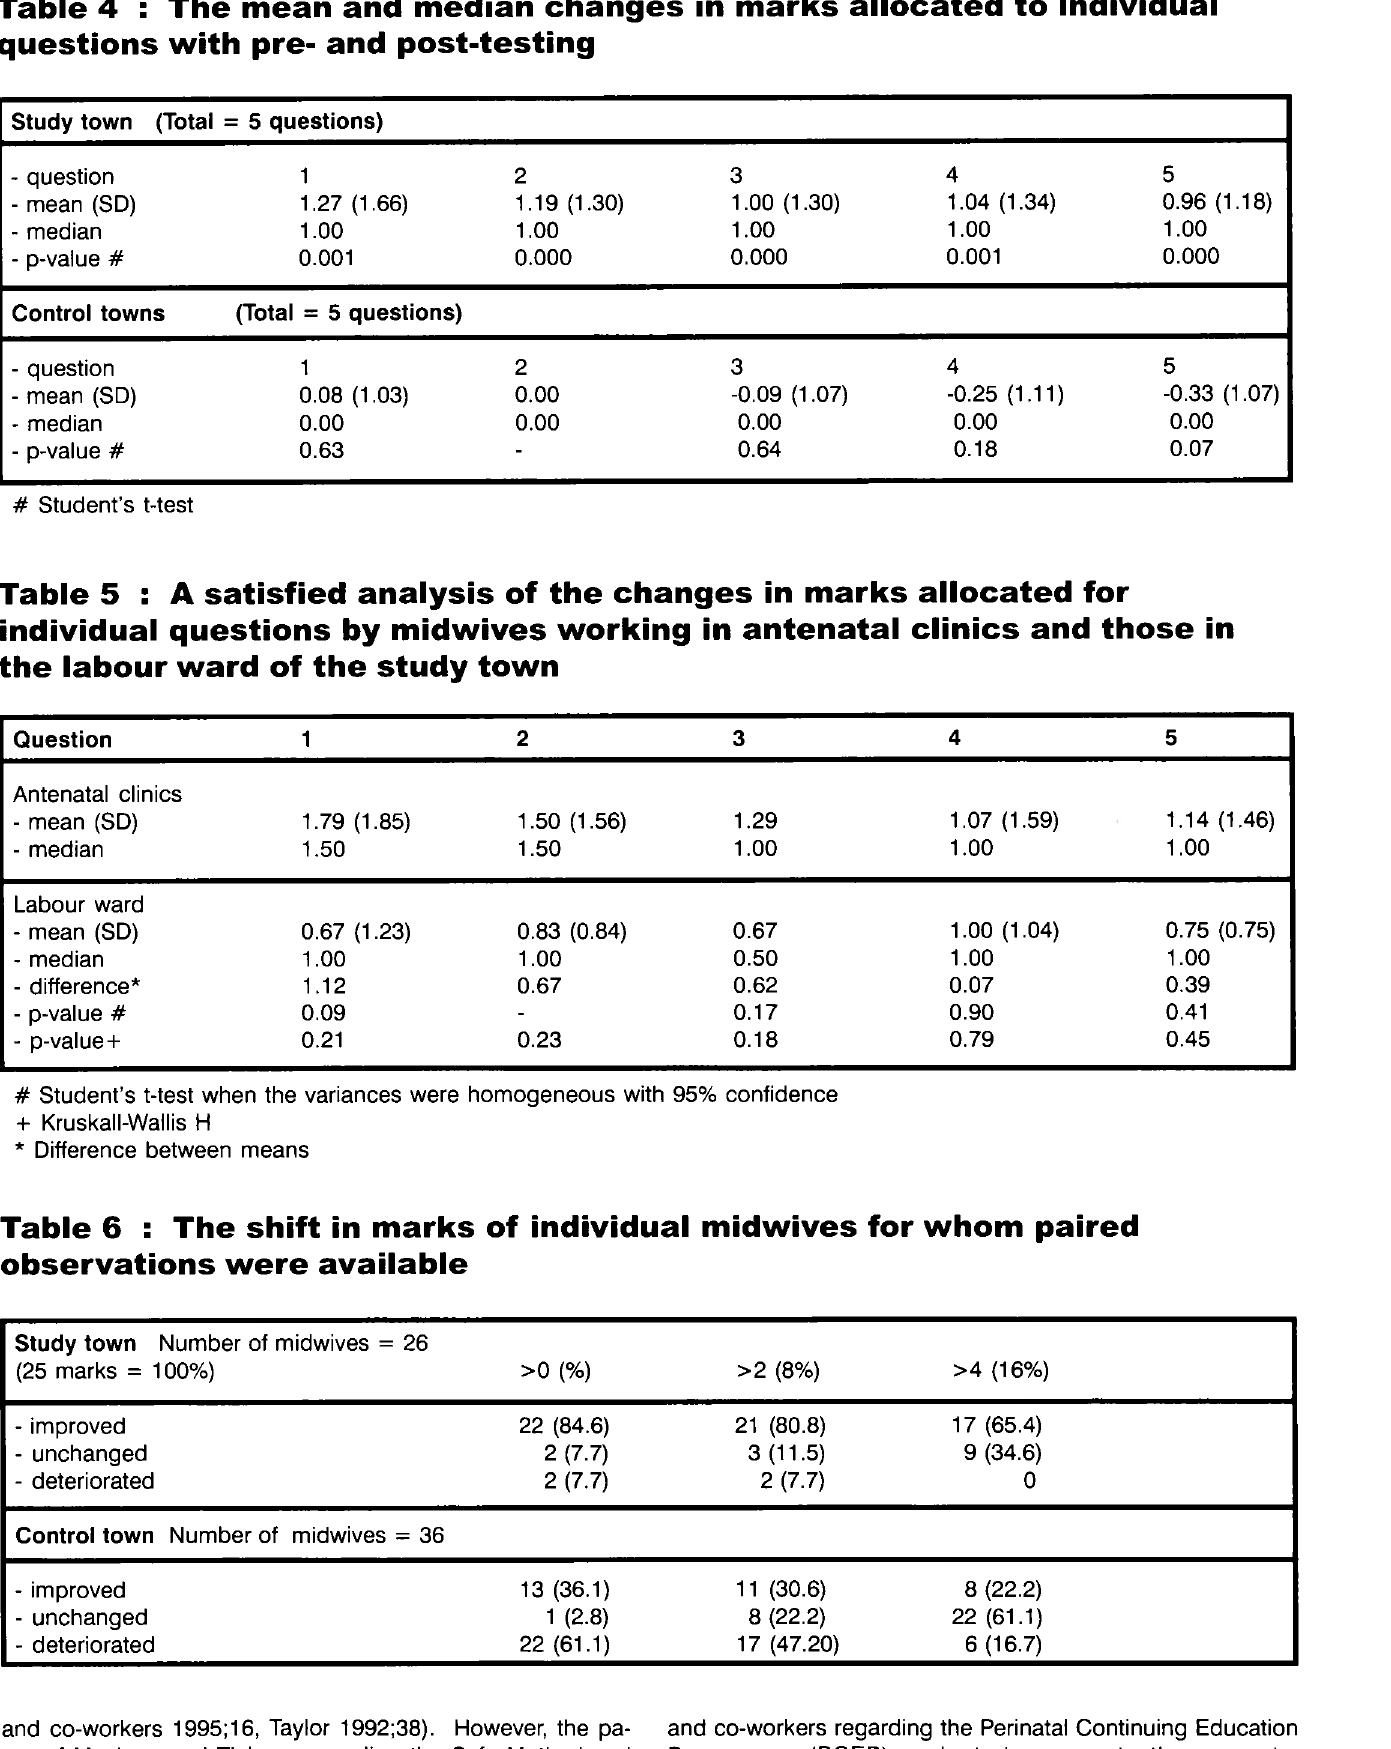
Table 4 : The mean and median changes in m arks allocated to individual questions w ith pre- and post-testing